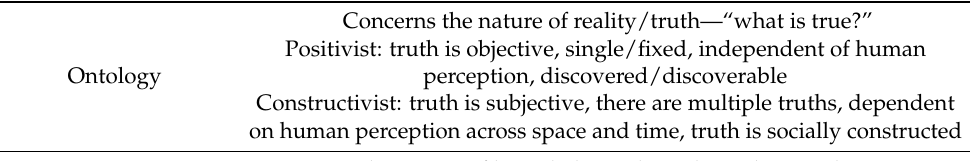
Table 1. Critical discourse analysis research